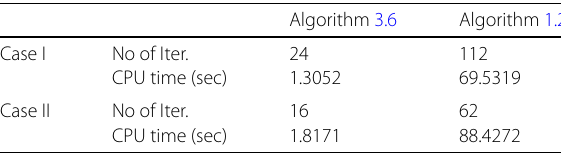
Table 2 Computation result for Example